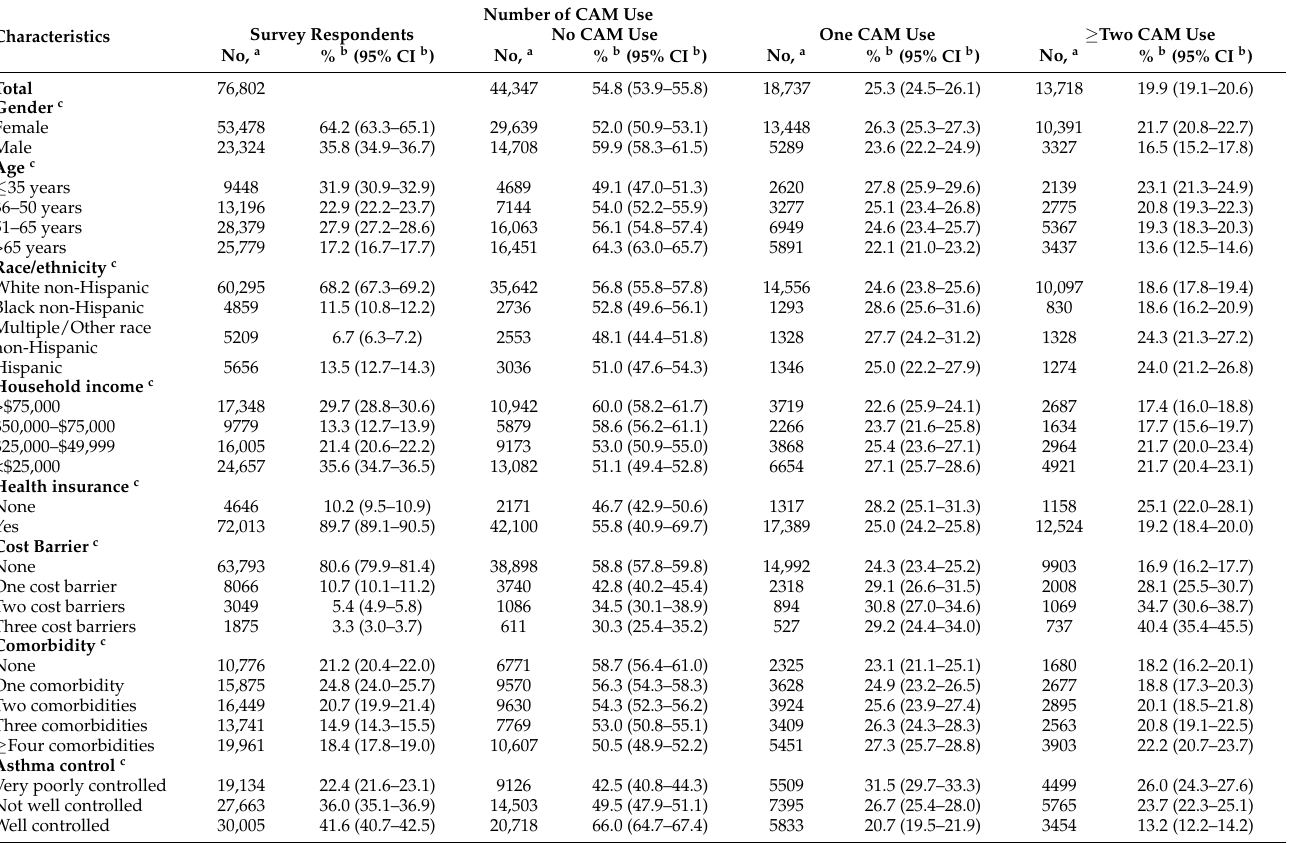
Table 2. Sociodemographic and health factors among US adults with current asthma: Behavioral Risk Factor Surveillance System Asthma Call-back Survey,